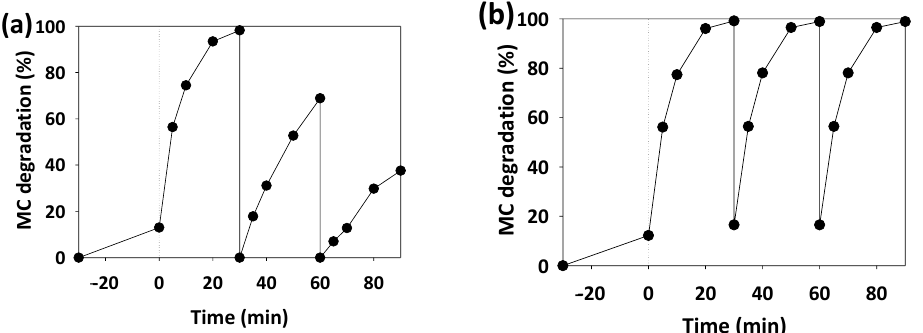
Figure 7. MC photodegradation under UV radiation (20 mg/L each cycle), using the same photocatalyst (at a concentration of 800 mg/L) during three cycles ( a ) and with the addition of 0.66 mg/mL of H 2 O 2 in each cycle ( b ).